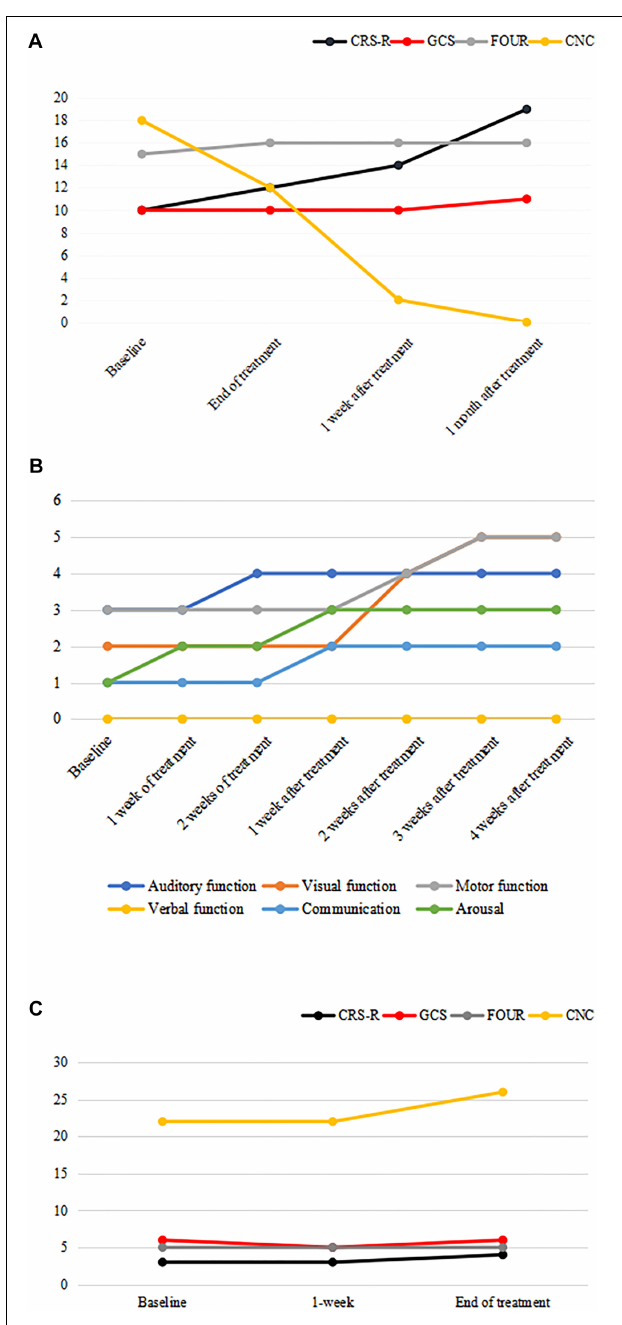
FIGURE 4 | Clinical scores before, during, and after treatment in patient 1 and patient 2. (A) The CRS-R, GCS, FOUR, and CNC scores in patient 1. Compared to baseline, the CRS-R and CNC scores improved considerably, and the effect lasted for up to 1 month. (B) The subscales of the CRS-R score in patient 1. The arousal and auditory functions were the first to show improvement during stimulation. Then, communication improved. Finally, visual function and motor function improved after stimulation treatment was completed. (C) The CRS-R, GCS, FOUR, and CNC scores in patient 2. Compared to baseline, the scores did not show much improvement after 2 weeks of treatment. CRS-R, Coma Recovery Scale-Revised; GCS, Glasgow Coma Scale; FOUR, Full Outline of UnResponsiveness; CNC, Coma/Near Coma